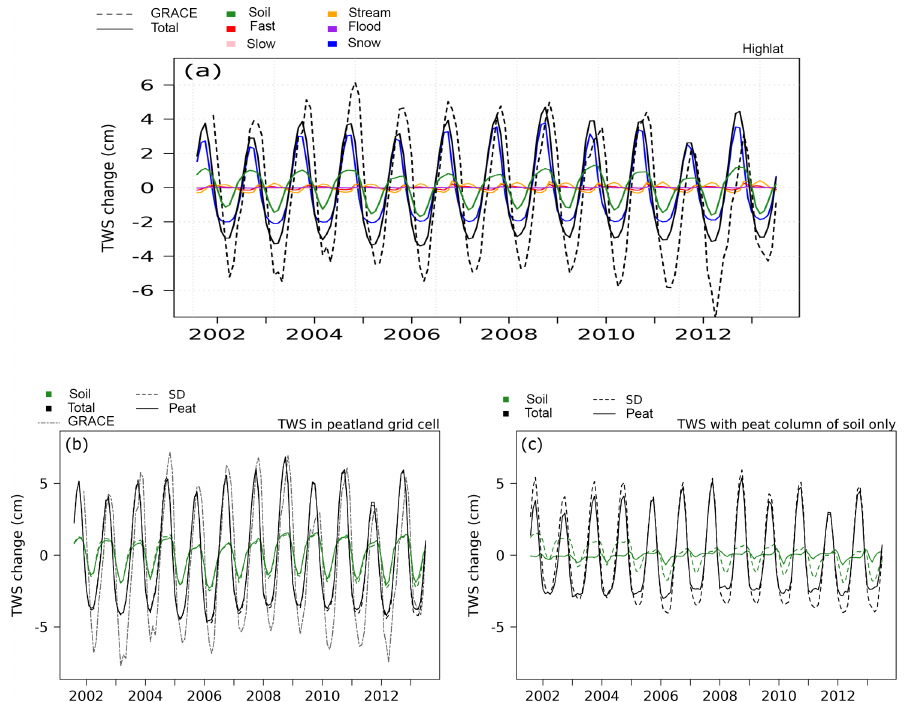
Figure 10. (a) Land surface above 45 ◦ N terrestrial water storage (TWS) and the contribution of each reservoir in the model. TWS variations of latitudes over 45 ◦ N (HIGHLAT) from GRACE (grey), the STD (black lines) and from the PEAT version (black dashed) for all peatlands grid cells with both peat and non-peat soil columns, (b) including the water reservoir variations in total soil moisture of the soil and (c) the variations in total soil moisture of the peat soil column